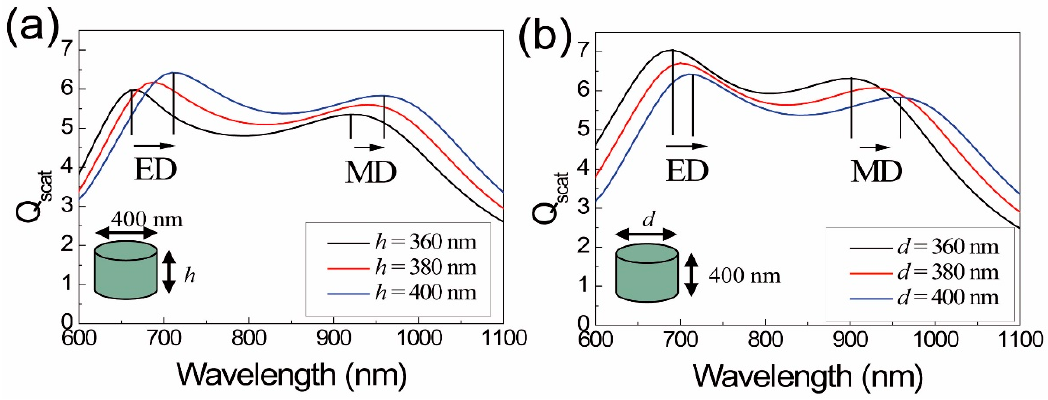
Figure 2. Normalized scattering cross section (Q scat ) as a function of wavelength for a nanocylinder with ( a ) a fixed diameter ( d ) of 400 nm and different heights ( h ) of 360 nm, 380 nm, and 400 nm; and ( b ) a fixed height ( h ) of 400 nm and different diameters ( d ) of 360 nm, 380 nm, and 400 nm. The resonant wavelengths of ED and MD increase with increasing h and d .